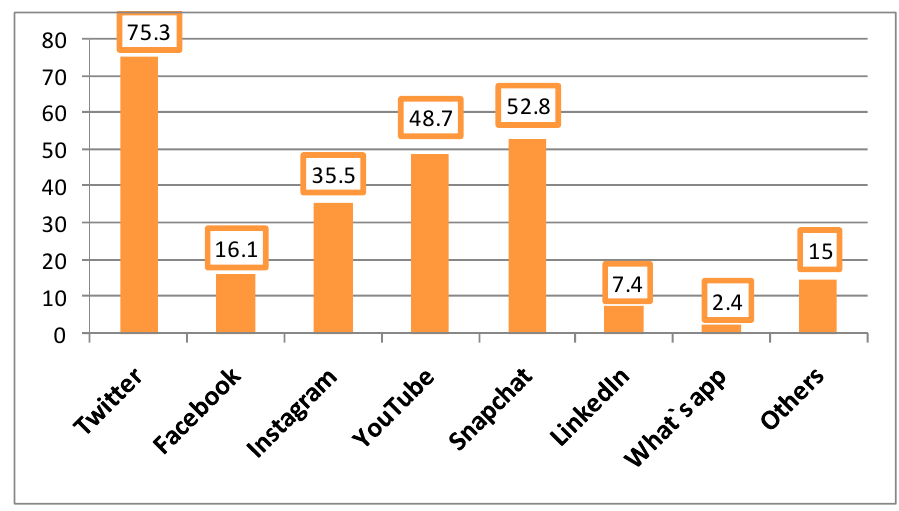
Figure 1. Social media sites frequently checked by the participants.